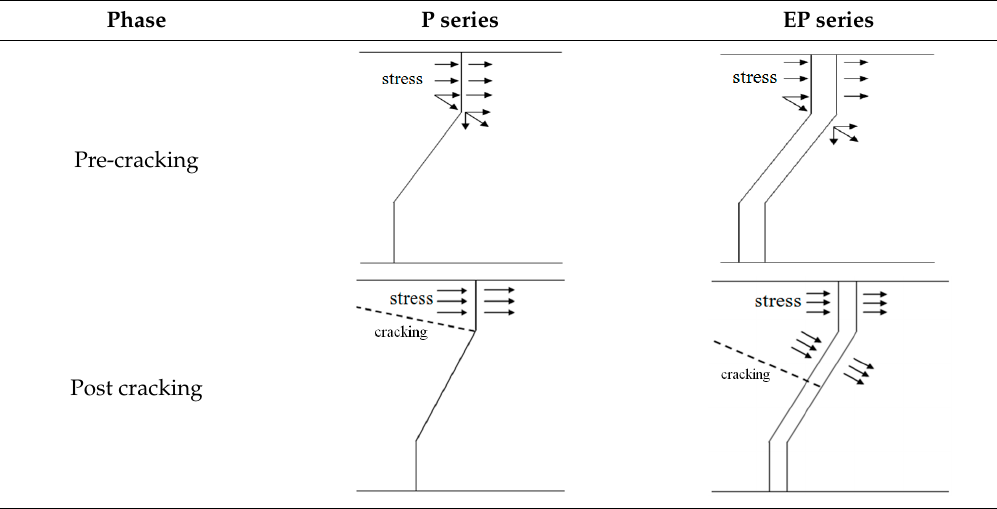
Figure 21. Stress diagram at interface.